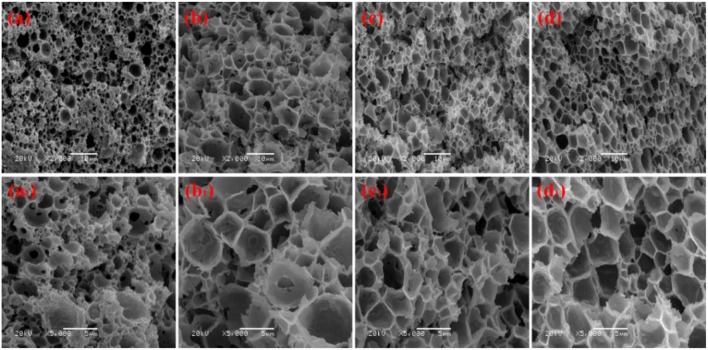
SEM of macroporous CMC-g-PAM/MMT with different MMT. Three percentage (a, a1, Sample 1); 5% (b, b1, Sample 2); 7% (c, c1, Sample 3); 9% (d, d1, Sample 4).